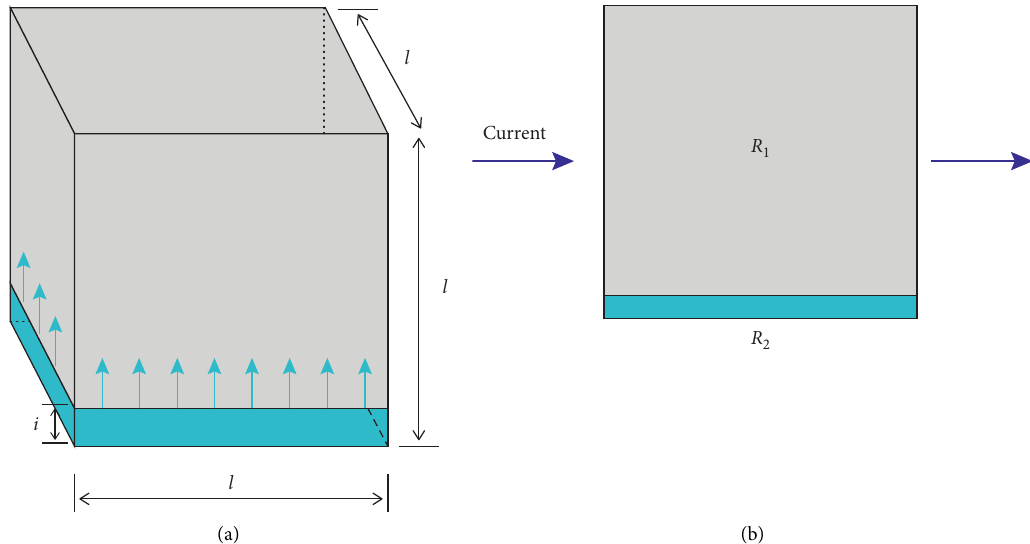
Figure 12: Schematic diagram of the electrical resistivity of the matrix under capillary water absorption: (a) capillary water absorption process; (b) parallel connection of two